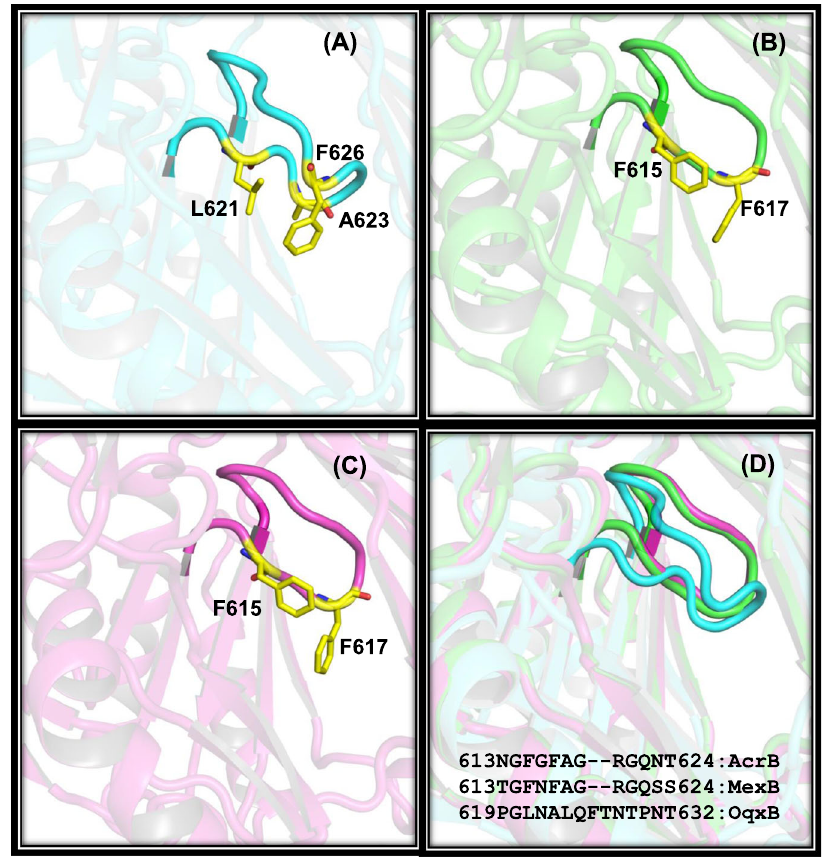
Fig. 4 The gate loop (g-loop) variations. Structural and sequence level differences of g-loop are shown by highlighted loop structure and important residues of OqxB ( A ), AcrB ( B ), and MexB ( C ). Important hydrophobic residues which are crucial for substrate binding were highlighted as yellow color sticks and labeled. All the three structures were superimposed to emphasize the g-loop orientational differences of OqxB comparing with the other two structures ( D ). Sequences of g-loop aligned to highlight the extra residues of OqxB. Table 1 MIC values with acrB and oqxB complementation in E. coli BW25113.